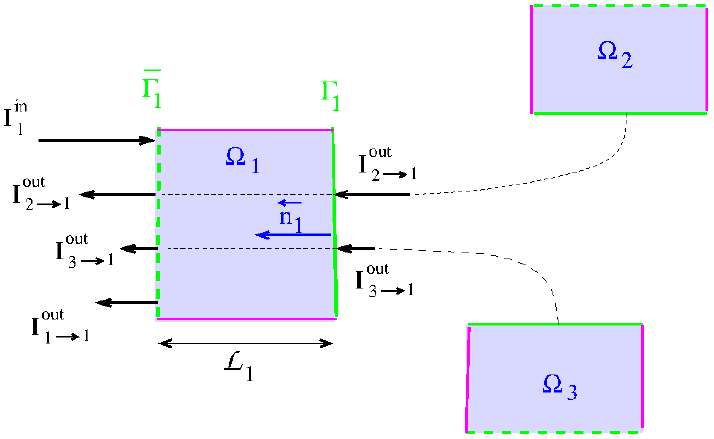
. The three current components 1